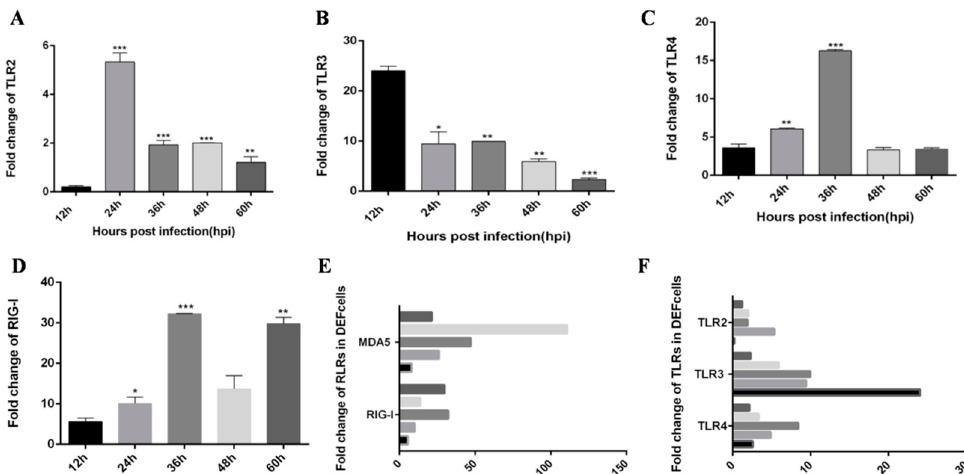
Figure 8. TLR3 and MDA5 play important immunity roles in DTMUV-infected DEF cells. DEF cells were infected with or without DTMUV and harvested at 12, 24, 36, 48, and 60 hpi. The qRT-PCR analysis was performed to examine the mRNA expression levels of RLRs ( D ), and Toll-like receptors (TLRs) ( A – C ). Comparison of TLRs and RLRs in DEF cells ( E , F ). The average levels from three independent experiments are plotted. The error bars represent the SEs. * P < 0.05, ** P < 0.01.